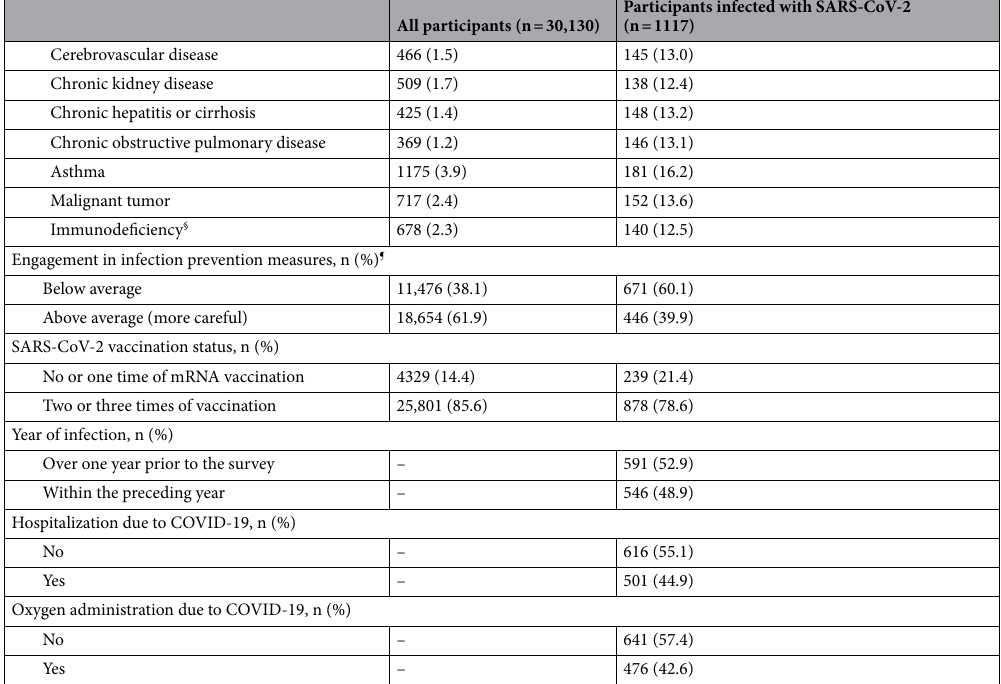
Table 1. Characteristics of participants. *Percentages in all participants (left column)/participants infected with SARS-CoV-2 (right column) (same as below). † 21 prefectures that had been declared the State of Emergency more than once. ‡ Under 18 years old. § Include use of corticosteroids, biologics, and immunosuppressive drugs. ¶ Percentage of 12 infection prevention behaviors being performed. n number (weighted by inverse probability weighting), SARS-CoV-2 severe acute respiratory syndrome coronavirus 2, HTPs heated tobacco products, METs metabolic equivalents, BMI body mass index, mRNA messenger ribonucleic acid, COVID-19 coronavirus disease